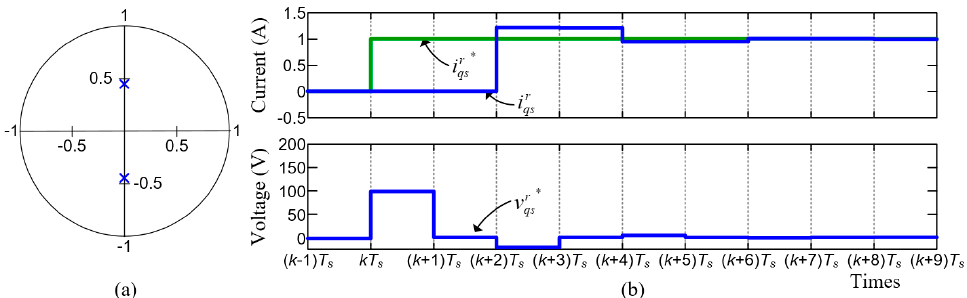
Figure 14. ( a ) The dominant poles and ( b ) simulated q -axis current and voltage command response with ˆ L qs = 1.2 L qs when the current command steps from 0 A to 1 A, the motor is at standstill.